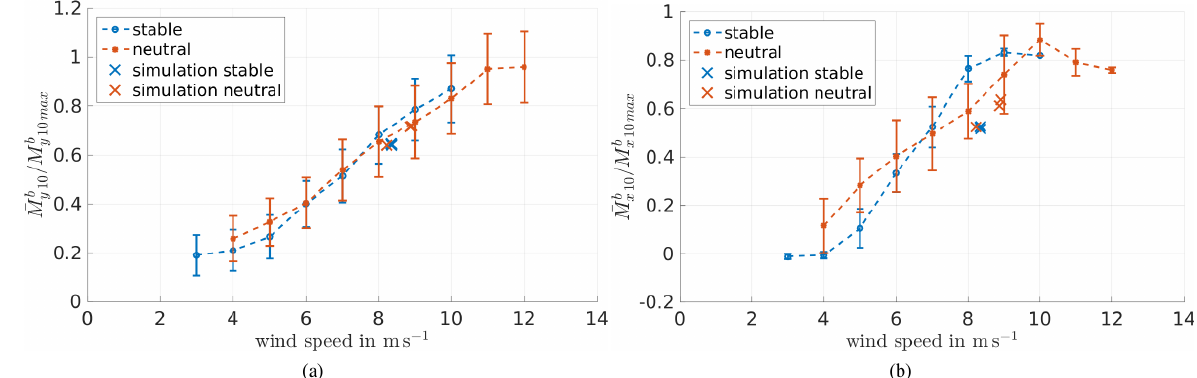
Figure 14. Blade root bending moment (a) out of plane M b y and (b) in plane M b x with respect to wind speed in comparison to the simulation results; averaged 10min values were sorted by stability, averaged according to wind speed and normalised with the maximum measured moment.